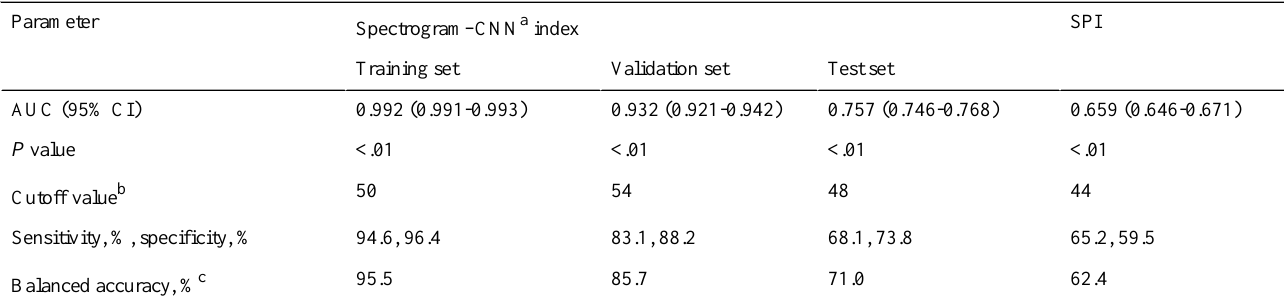
Table 2. Areas under the receiver-operating characteristic curves (AUCs) and cutoff values for assessing pain in the spectrogram-convolutional neural network index and surgical pleth index (SPI) in surgical patients.